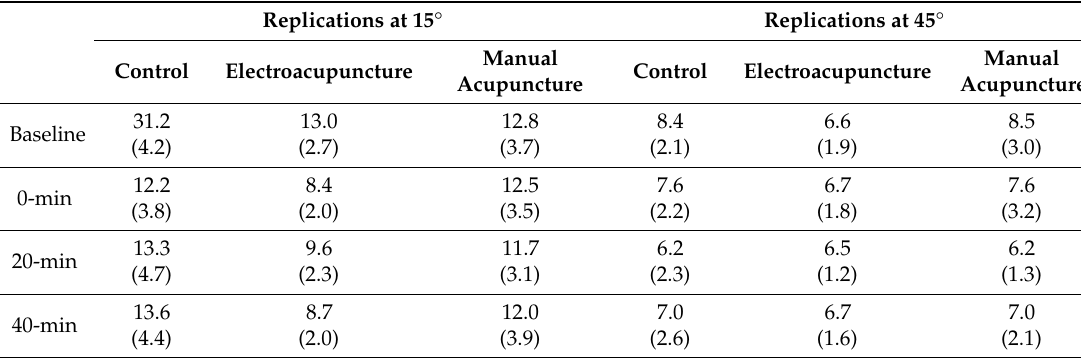
Table 4. Changes in knee joint function. Values are mean (95% confidence